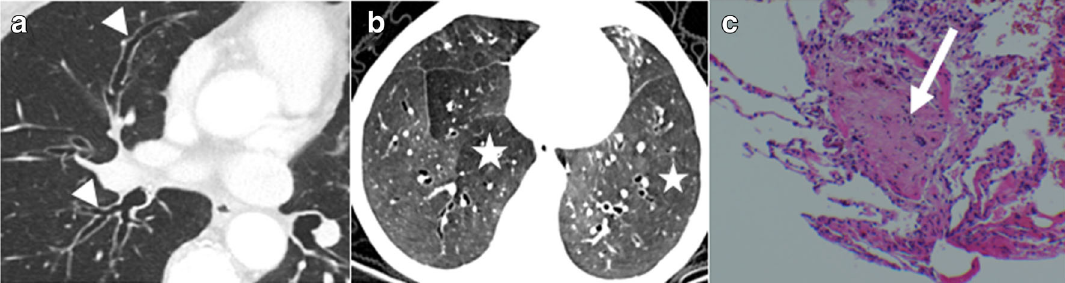
Fig. 10 Bronchiolitis obliterans syndrome (BOS). Chronic dyspnea with obstructive pattern at functional tests. Bronchiectases, bronchial thickening ( arrowheads ) ( a ) and mosaic perfusion on minimal intensity